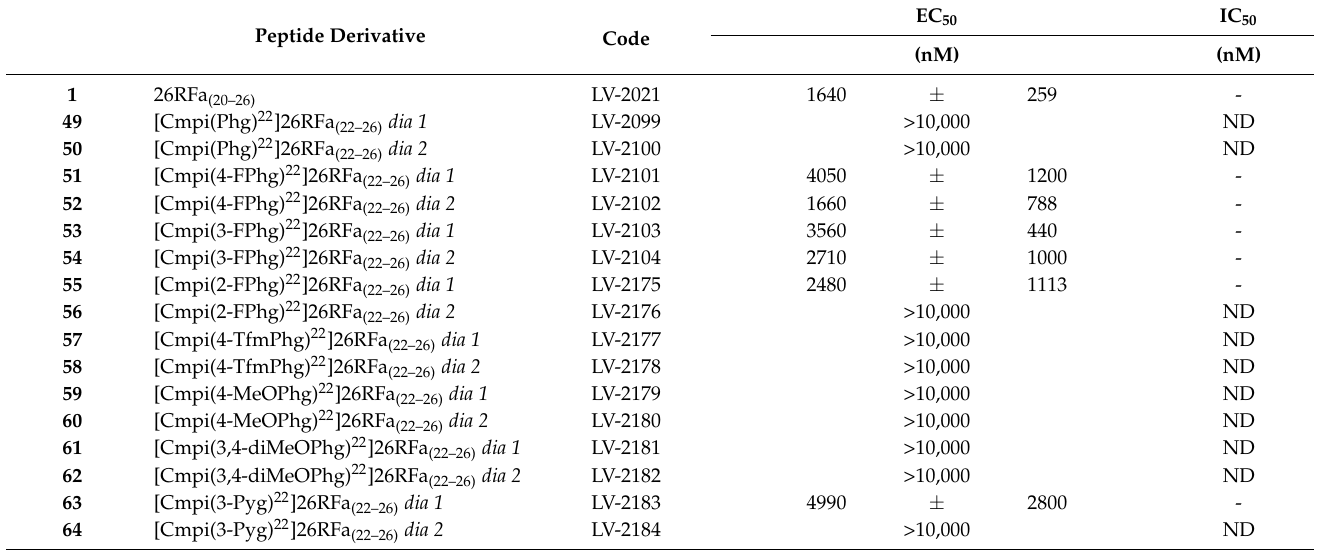
Table 4. Biological data for 26RFa (22–26)